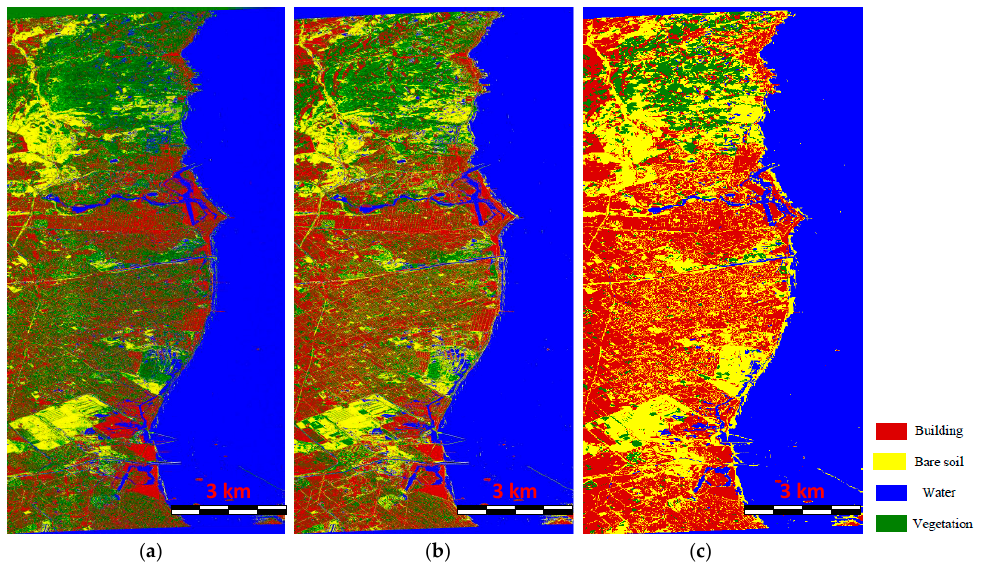
Figure 10. Classification results of the AIRSAR image: ( a ) result of the MCSM-SVM method; ( b ) result of the LE-IF KNN method; ( c ) result of our proposed method.